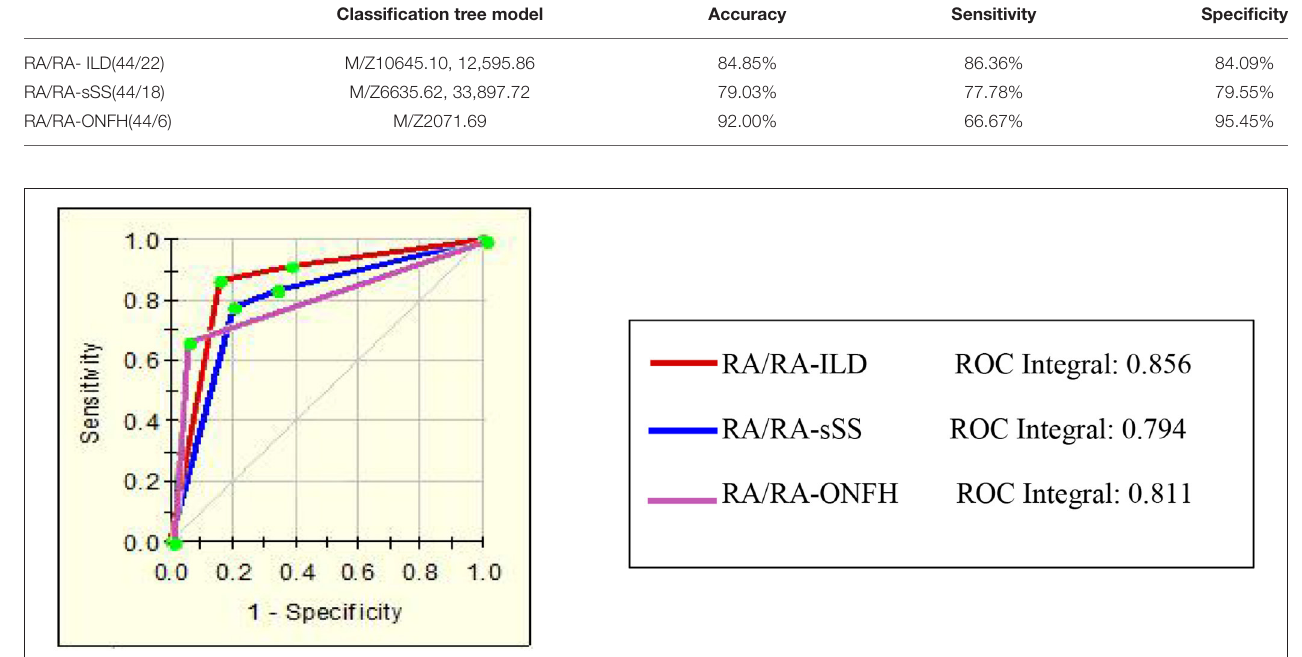
FIGURE 5 | The ROC of the diagnostic models of RA with